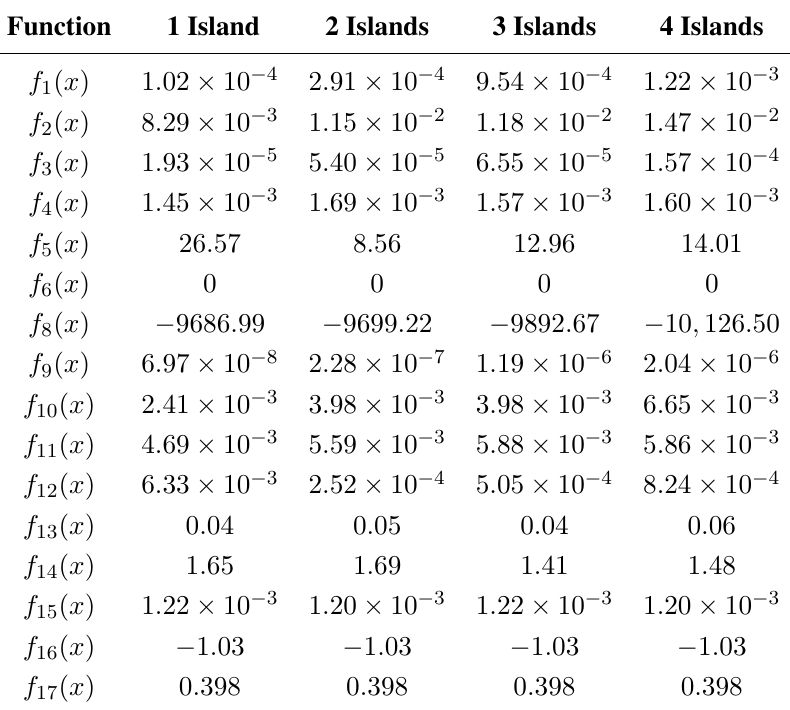
Table 2. Average optimality comparison with different number of